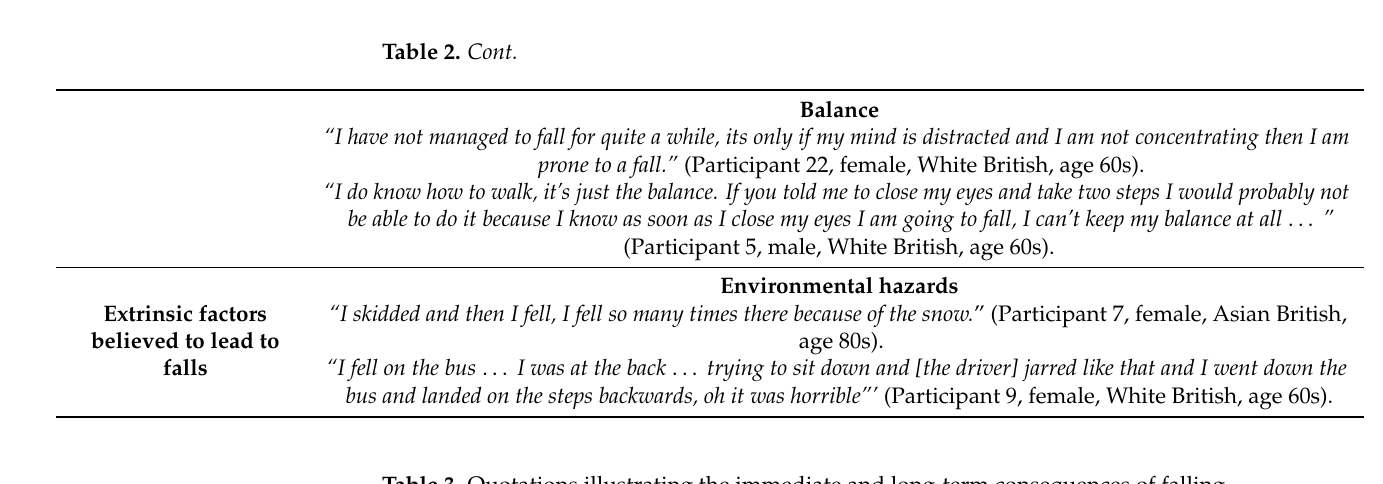
Table 3. Quotations illustrating the immediate and long-term consequences of